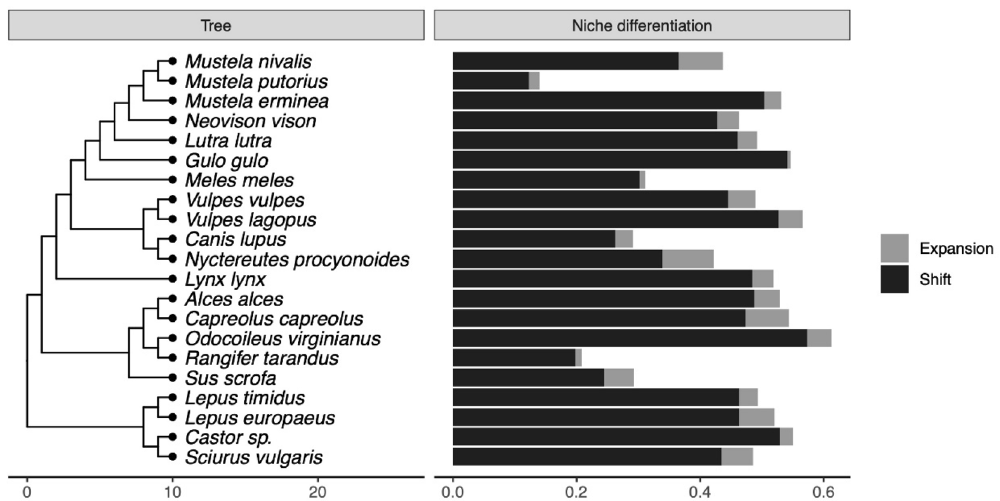
Figure 4. Species specific responses of mammals in terms of habitat shift (black) and niche expansion (or contraction; grey). The sum of niche expansion/contraction and shift (depicted with different colors) gives the total niche differentiation between protected and unprotected areas, following Ref. 22 . The phylogeny of the species is shown in the